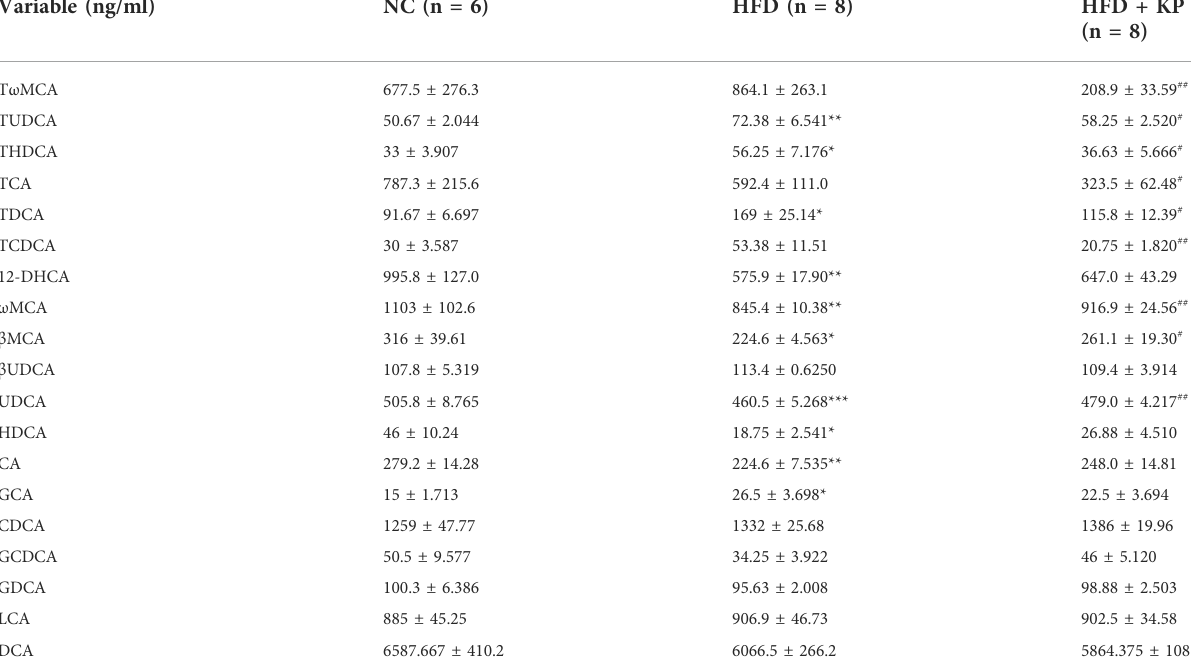
TABLE 1 Serum BA levels in different